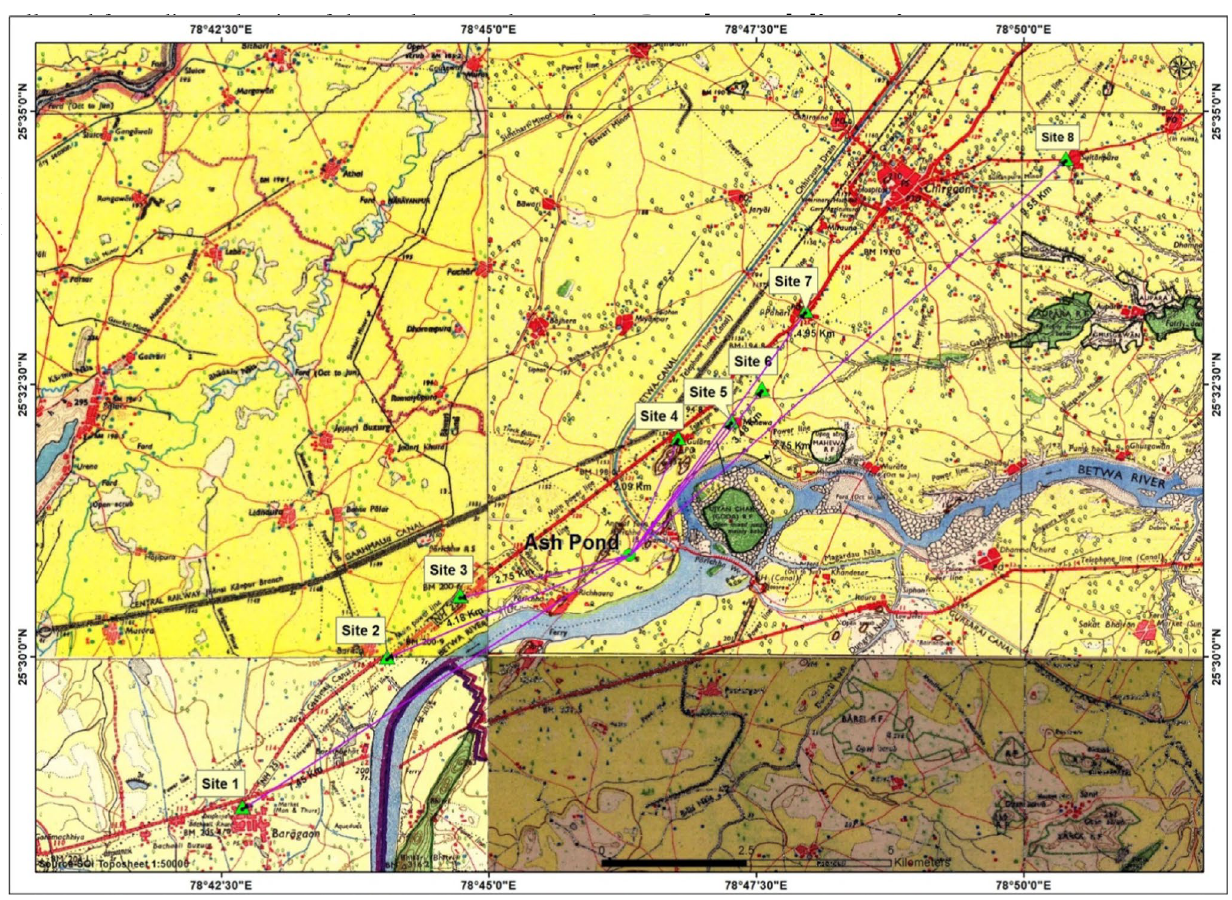
Fig. 2 Map showing groundwater sampling sites around ash pond of Parichha Thermal Power